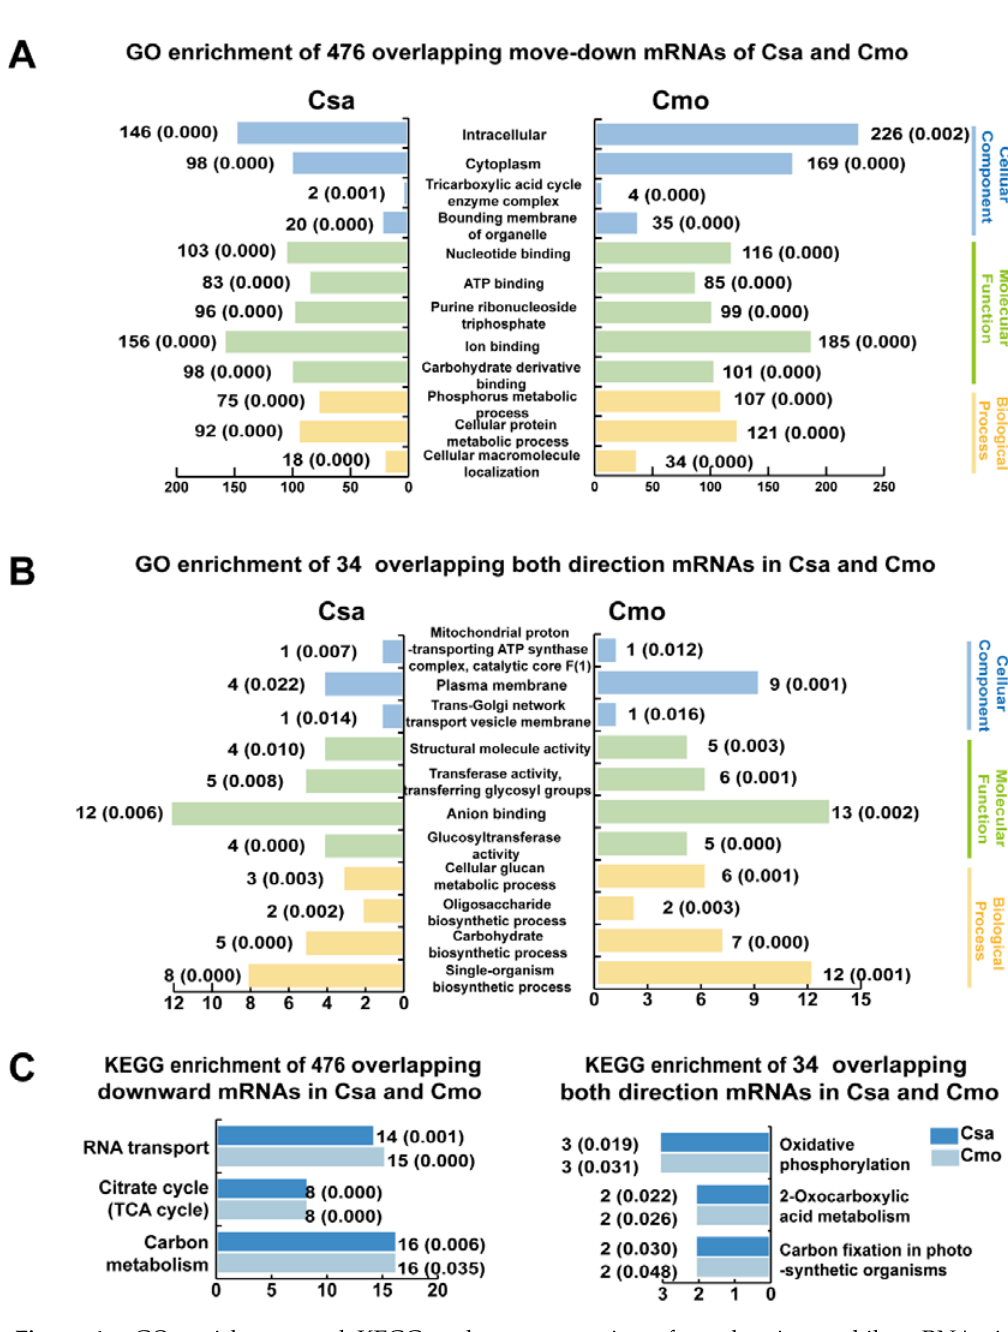
Figure 4. GO enrichment and KEGG pathway annotation of overlapping mobile mRNAs in all directions. ( A , B ) GO enrichment and ( C ) KEGG pathway analysis of overlapping mobile mRNAs in different directions. GO enrichment and KEGG pathway analysis was performed using the OmicShare tools, a free online platform for data analysis (http://www.omicshare.com/tools). Graphs were generated by EXCEL (Office 2010) and colored graphs indicate the classifications of molecular function, cellular component, and biological process. The numbers beside each graph represent the number of genes in the cluster and the p value.